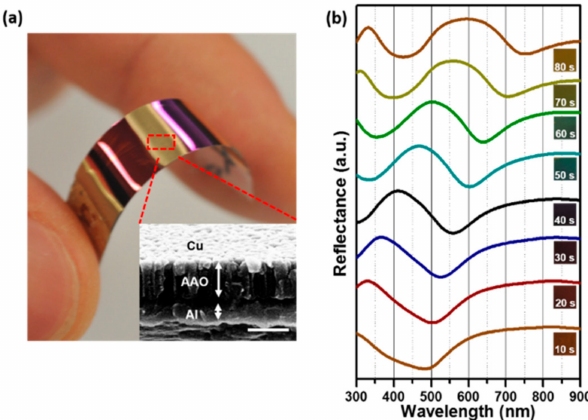
Figure 8. Photograph of a copper (Cu)-coated QU-AAO template and the corresponding reflectance spectra. ( a ) Large-area of flexible plasmonic nanostructures can be made with QU-AAO devices developed in this paper. The scale bar is 400 nm. ( b ) Optical reflectance spectra of the devices as a function of the anodization time ( t A ). The graphs are shifted in the y -axis for clarity.